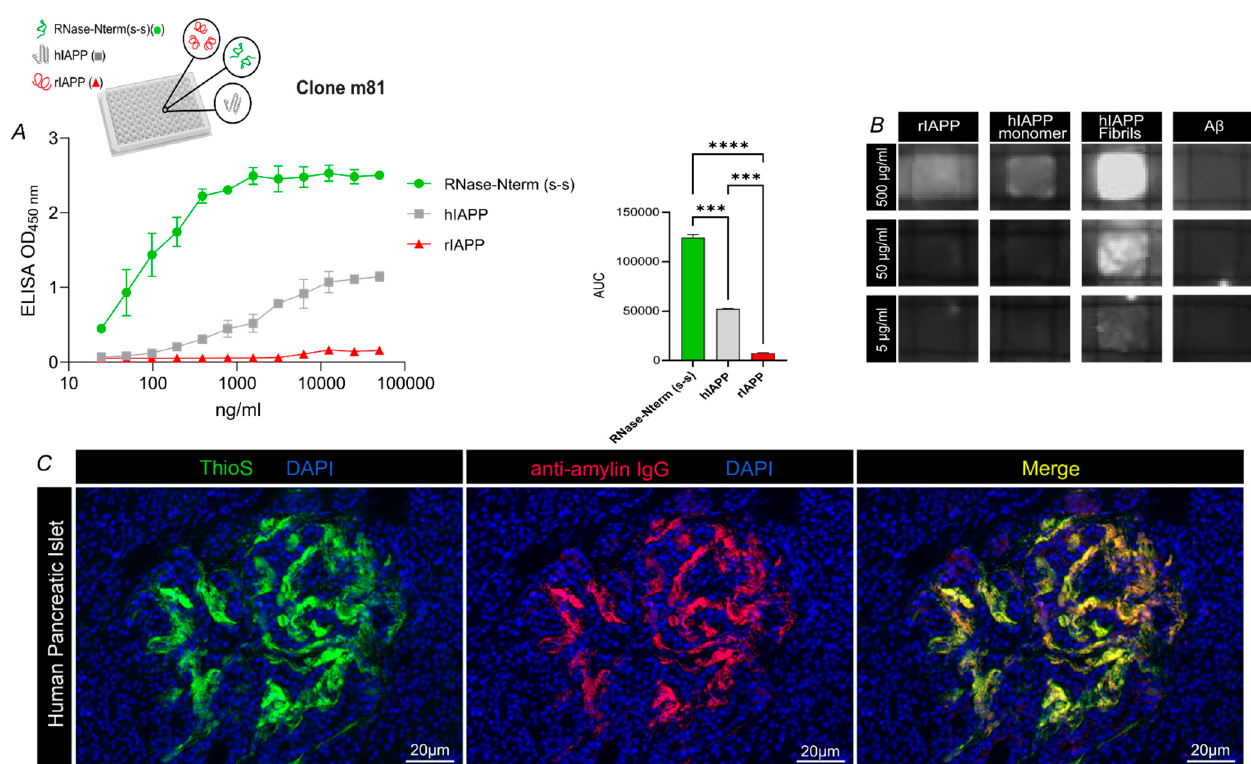
Figure 2. m81 mAb is specific for human IAPP fibrils, but not rat IAPP nor monomeric human IAPP. ( A ) Purified m81 mAb tested in an ELISA assay with either RNase-Nterm(S-S) (green circle), hIAPP (grey square), or rIAPP (red triangle) coating, with the corresponding area under the curve (AUC). Statistics were performed by one-way ANOVA using Tukey’s multiple comparison test, where the mean of each group was compared to the other groups. *** p < 0.001 and **** p < 0.0001. Data are presented as mean ± SEM. ( B ) Specificity for rIAPP, hIAPP monomer, hIAPP fibrils, and a negative control amyloidogenic A β peptide was tested on a dot blot at 500, 50, and 5 µ g/mL. ( C ) Representative human pancreatic islet from a patient suffering from T2DM. Amyloidogenic aggregates were stained with ThioflavinS dye (ThioS, left panel, green) and purified m81 mAb(m81, middle panel, red). A merge image was created to visualize co-localization (Merge, right panel, yellow). RNase-Nterm(S-S), N terminal peptide with disulfide bridge (S-S); rIAPP, rat IAPP; hIAPP, human IAPP; A β , Amyloid beta; ThioS, ThioflavinS; T2DM. Scale bars: 20 μ m.